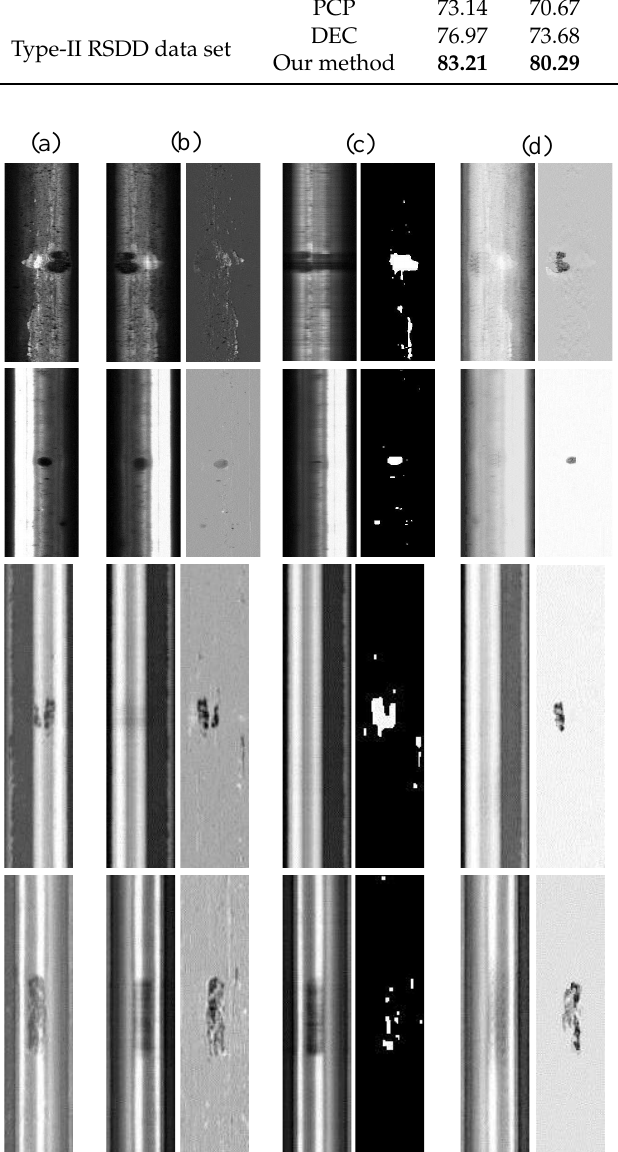
Figure 10. Background and foreground sample decomposition results using ( a ) defect images of different models, ( b ) PCP, ( c ) DEC, and ( d ) our